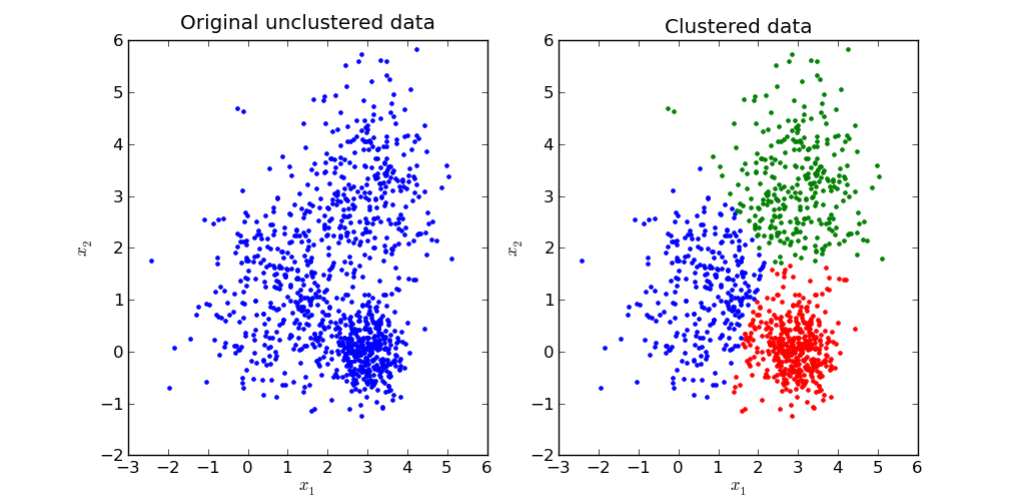
Figure 4. A sample of clusters found from unlabeled data: on the left the original 2D data, on the right clustered data, where different colors denote different